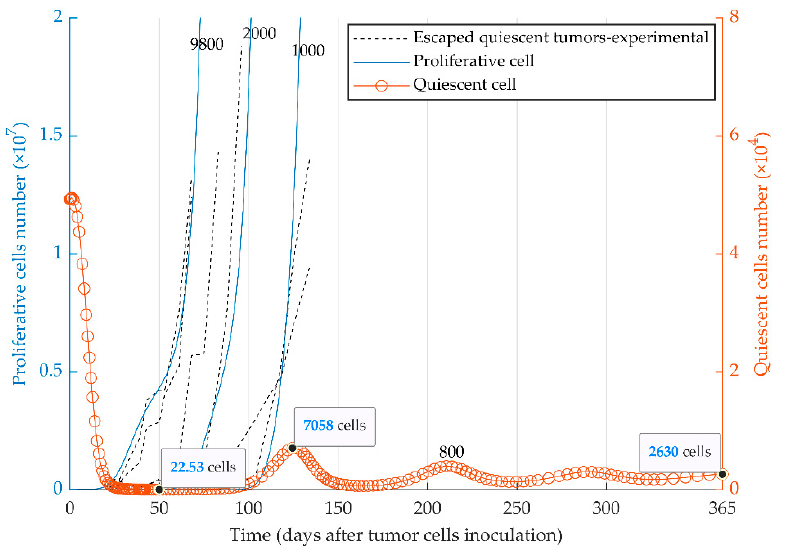
Figure 4. Mathematical simulation of the fate of heterogeneous tumors. Two subpopulations, pro- liferative (blue curve) and quiescent (red curve), are present within the 5 × 10 4 injected tumor cells. The fate of the tumor is represented by the simulation with four different initial numbers of prolif- erative cells: 8 × 10 2 , 1 × 10 3 , 2 × 10 3 , 9.8 × 10 3 . Experimental graphs for escaped tumors [51] are also replicated in the figure. Due to different scales, the left and right y -axes present the number of proliferative and quiescent tumor cells, respectively. The elimination events, where the number of tumor cells becomes smaller than one during the simulation, are not shown due to the large scale of the diagram.